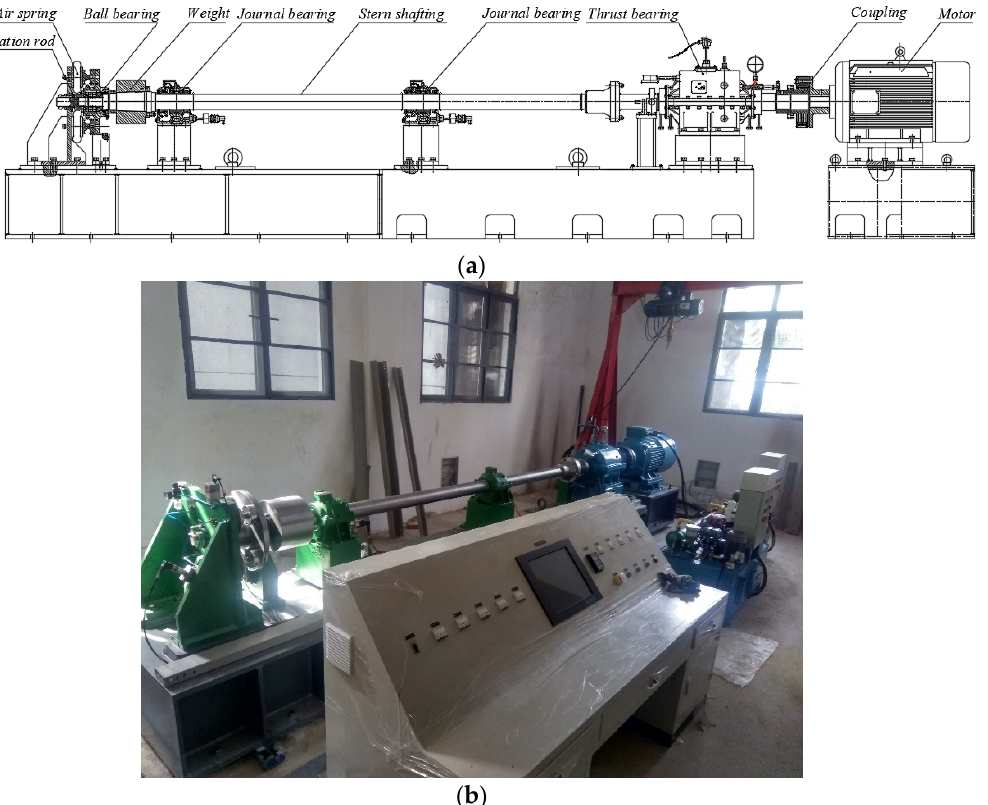
Figure 8. The designed test rig with a reduced scale in the laboratory: ( a ) schematic diagram; ( b ) photograph.